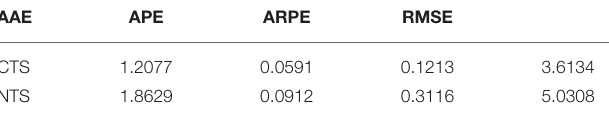
TABLE 13 | Errors of minimal entropy